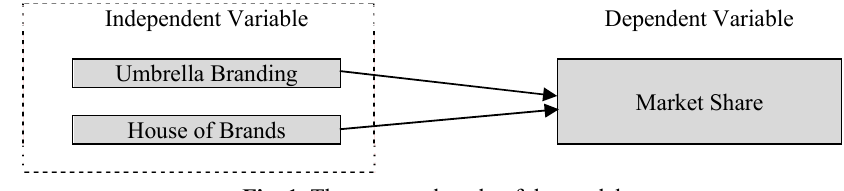
Fig. 1. The proposed study of the